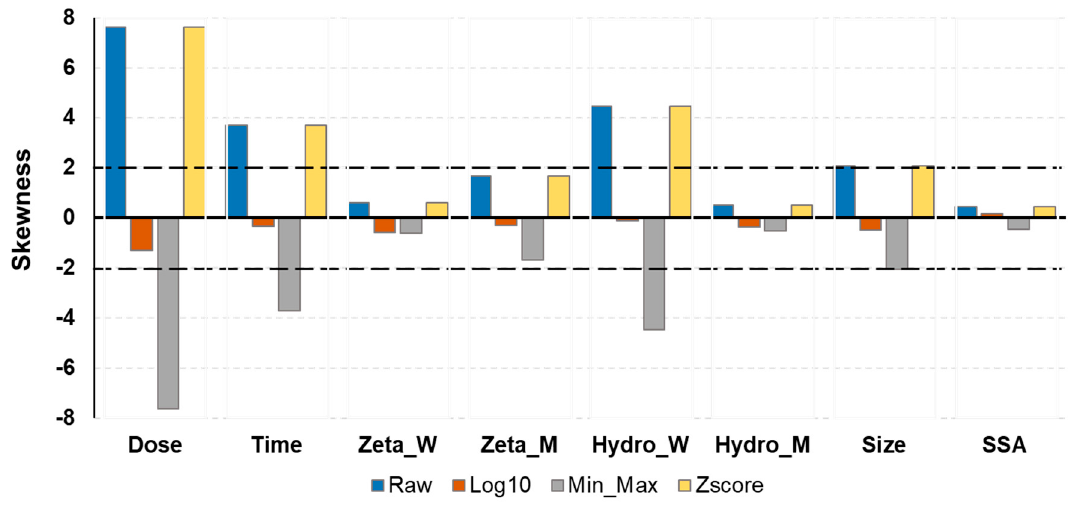
Figure 3. Skewness of numeric inputs based on different normalization methods. Four datasets were tested for their distribution of data, raw dataset (no normalization), log10, min-max, and zscore dataset. Inputs normalized with log10 had skewness closer to zero for all attributes, which means that